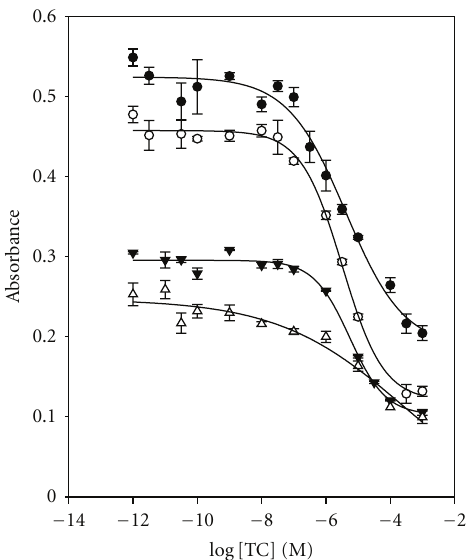
Figure 7: Optimization of the concentration of RNA aptamer: ( • ) 0.1 μ g mL − 1 , ( ◦ ) 0.07 μ g mL − 1 , ( (cid:3) ) 0.05 μ gmL − 1 , and ( (cid:5) ) 0.02 μ